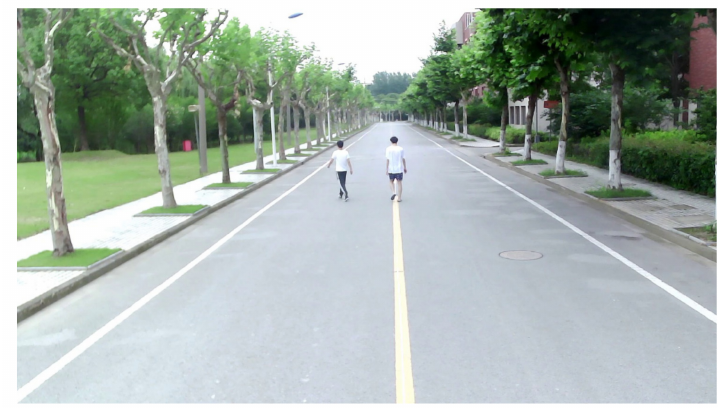
Figure 10. Pedestrian crosswalk tracking